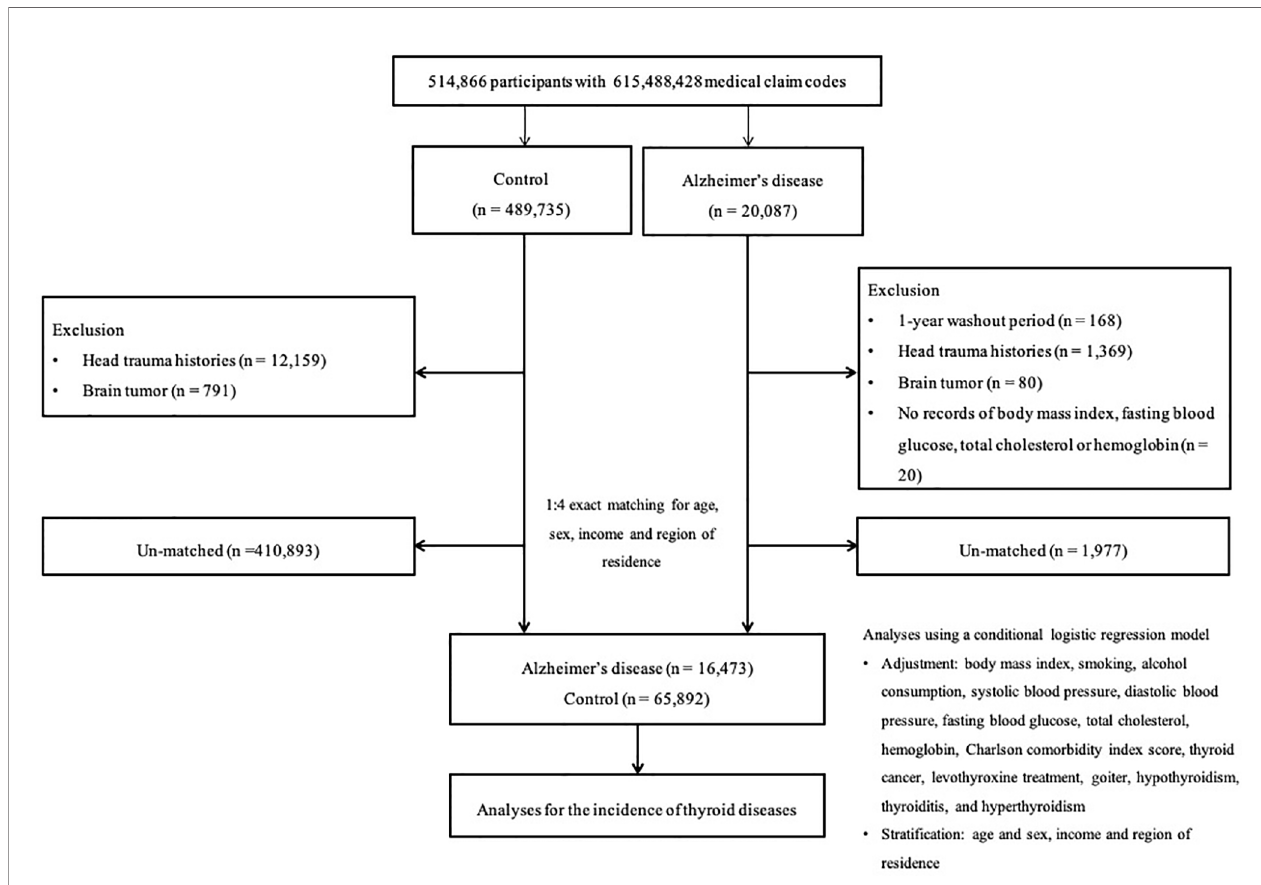
FIGURE 1 | A schematic illustration of the participant selection process that was used in the present study. Of 514,866 participants, 16,473 Alzheimer ’ s disease participants were matched 1:4 with 65,892 control participants for age, sex, income, and region of